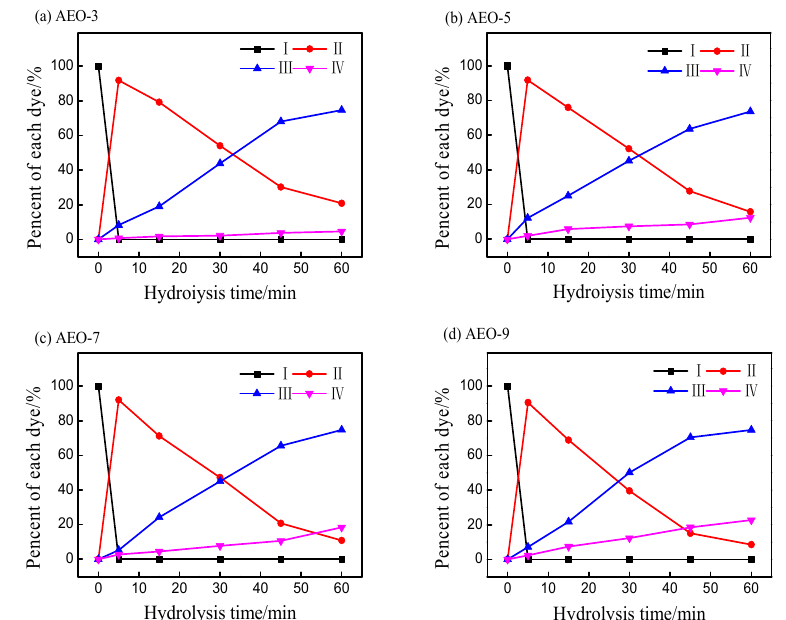
Figure 4. Percent of each peak’s area with the hydrolysis time in siloxane dyeing system at 70 °C: ( a ) AEO-3, ( b ) AEO-5, ( c ) AEO-7, ( d ) AEO-9, and the concentration of surfactants were 4.60 mmol/L.